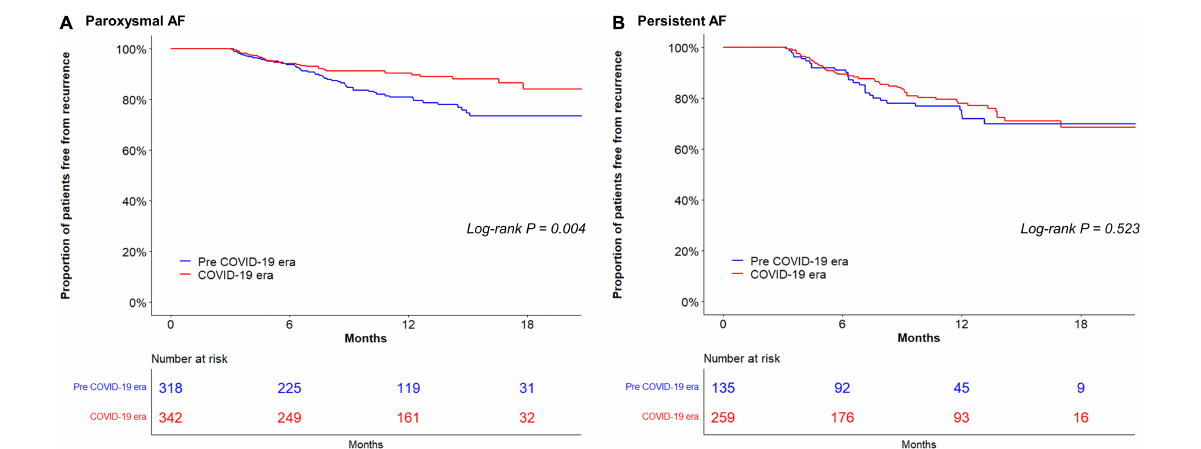
A two-sided P -value of less than 0.05 was considered statistically significant. Statistical analyses were performed using R version 4.0.2 software (The R Foundation).